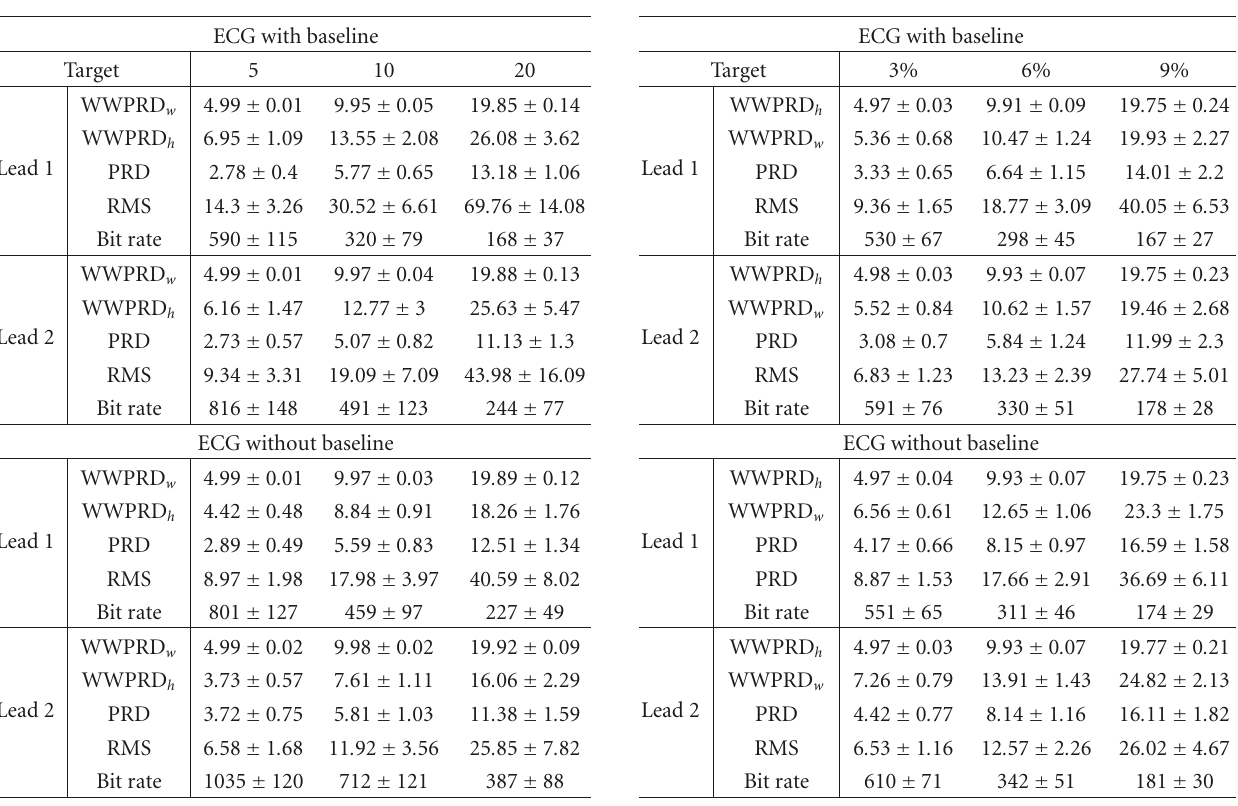
Table 3: Results when guaranteeing WWPRD h in MIT-BIH